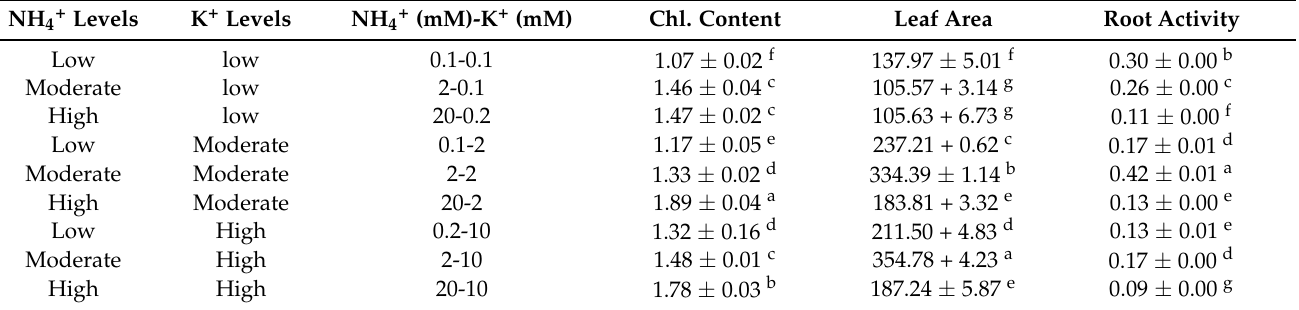
Table 2. Chlorophyll content (mg L − 1 ), leaf area (cm 2 ), and root activity mg/g (fresh root weight)/h of tobacco seedlings under different NH 4+ and K +